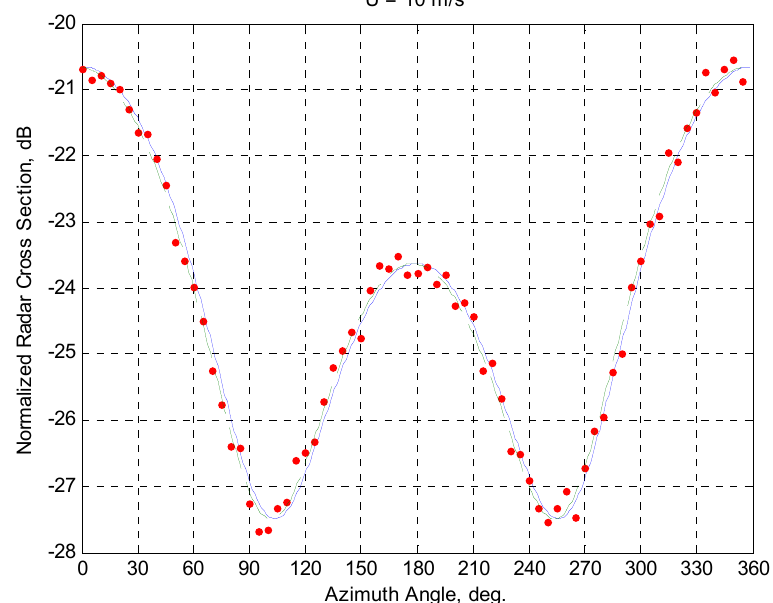
Figure 5. Azimuth NRCS curve using Equation (1) at the incidence angle of 45 ˝ , “true” wind speed of 10 m/s and “true” up-wind direction of 0 ˝ (solid line); generated “measured” NRCS with taking into account the instrumental noise of 0.2 dB after the averaging of 1565 samples in a five-degree azimuth sector (red dots); and azimuth NRCS curve using Equation (1) corresponding to “measured” wind speed of 9.994 m/s and up-wind direction of 357.9 ˝ retrieved from the azimuth sector of [ ´ 90 ˝ , 90 ˝ ] (dashed